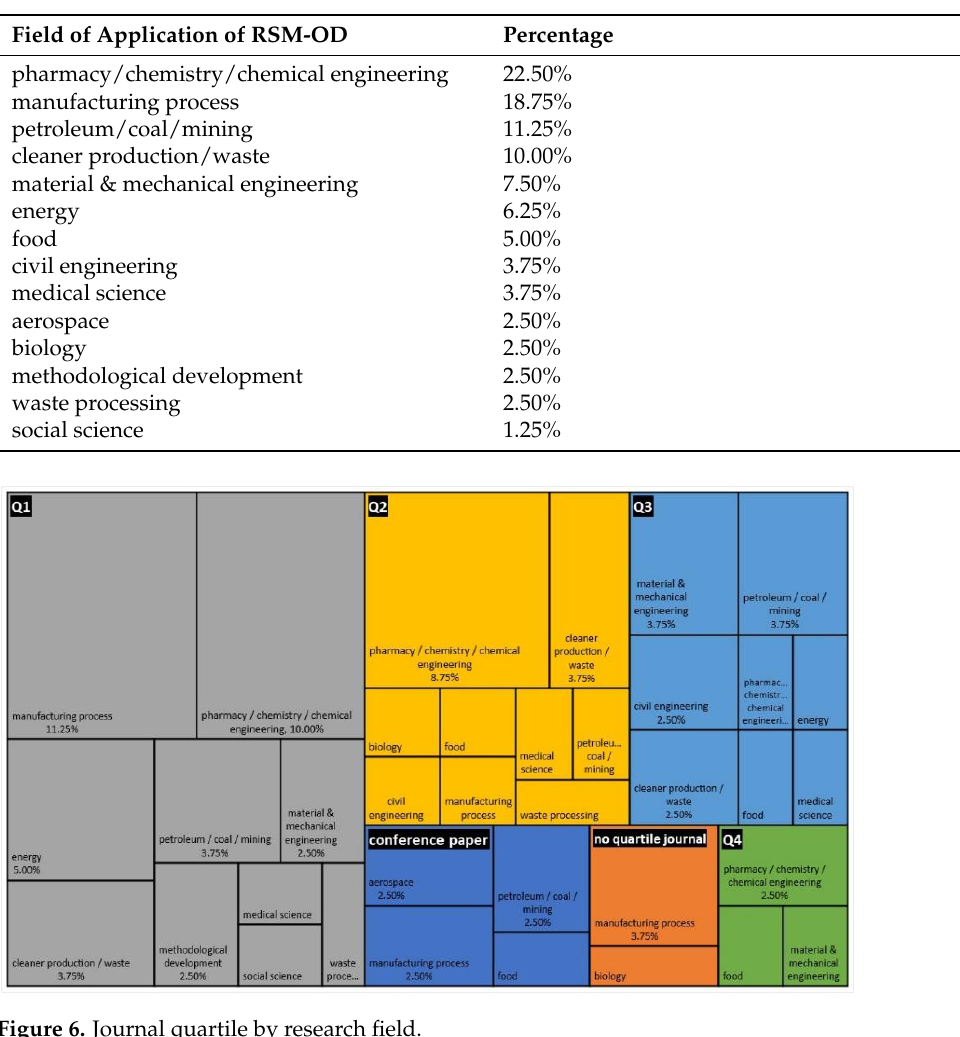
Table 2. Distribution of papers based on research fields.